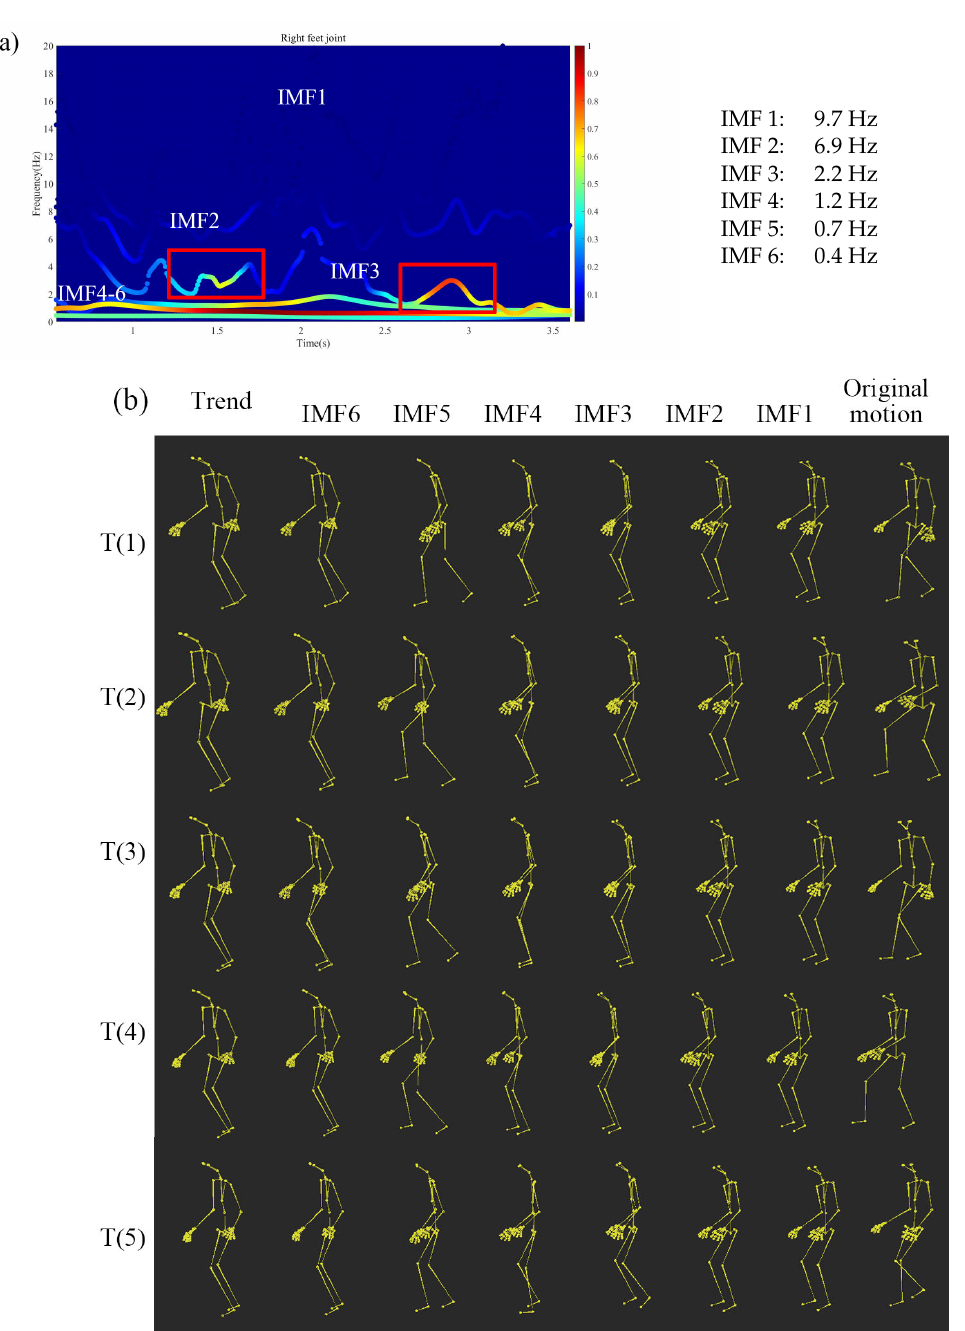
Figure 6. Decomposed gait motions of foot injured subject using our proposed framework. ( a ) The spectrum of the injured right foot joint. ( b ) Each of the IMFs and the trend motions decomposed by MEMD. Here, T(1)–T(5) correspond to the time 0.5 s, 1.2 s, 2.0 s, 2.8 s, and 3.5